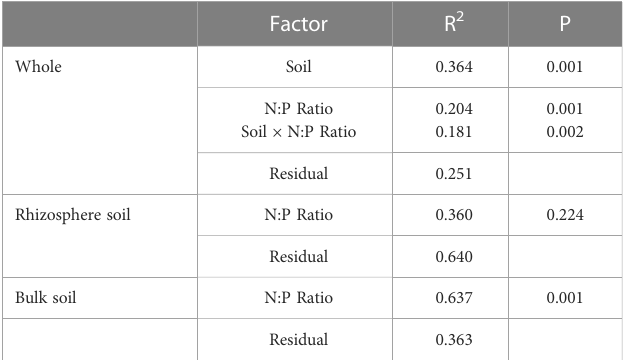
TABLE 3 PERMANOVA test (per = 999) of bacterial community in rhizosphere and bulk soil of S. salsa in different N-P addition ratio treatments.